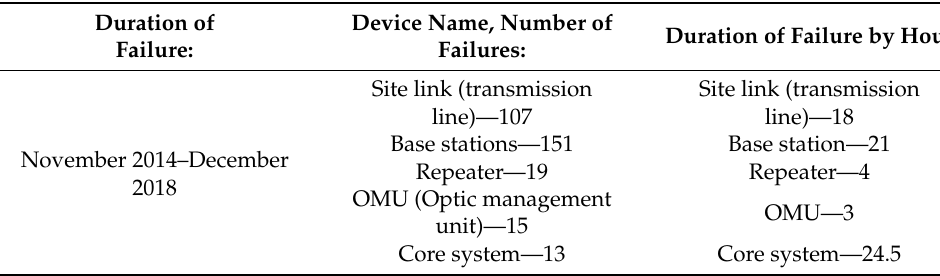
Figure 1. The general structure of an underground mine communication system with three shafts. The causes of failure and the number of failures per communication system device at the Oyu Tolgoi mine in 2014–2018 were included in the statistical data, as shown in Table 1 (see Supplementary Materials). Table 1. Number of failures of communication system components.